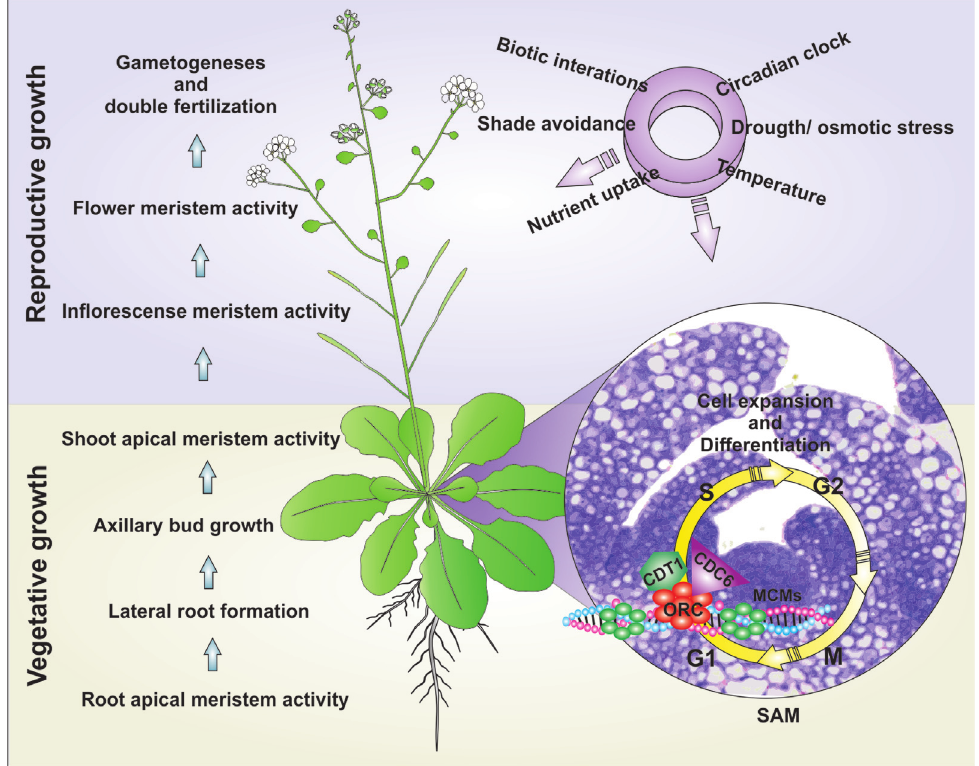
Figure 1 - Overview of cell cycle control modulation at meristems by endogenous and exogenous signals. Plants are continuously sensing the environ- ment and modulating their development by adjusting cell division and differentiation rates at the different meristems. This means that every plant meristem might be sensing exogenous signals and integrating with genetic controls, which leads to changes in gene expression that will finally balance cell proliferation and differentiation rates, culminating with the correct plant form. The shoot apical meristem (SAM) is represented in the right panel. An important control of the G1 to S transition of the cycle is the pre-replication complex (pre-RC) that might be continuously regulated, although by some different mechanisms, along